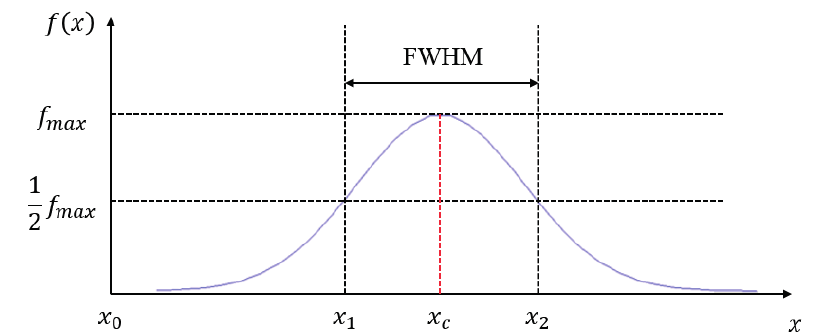
Figure 5. Laser intensity function and the centroid position.